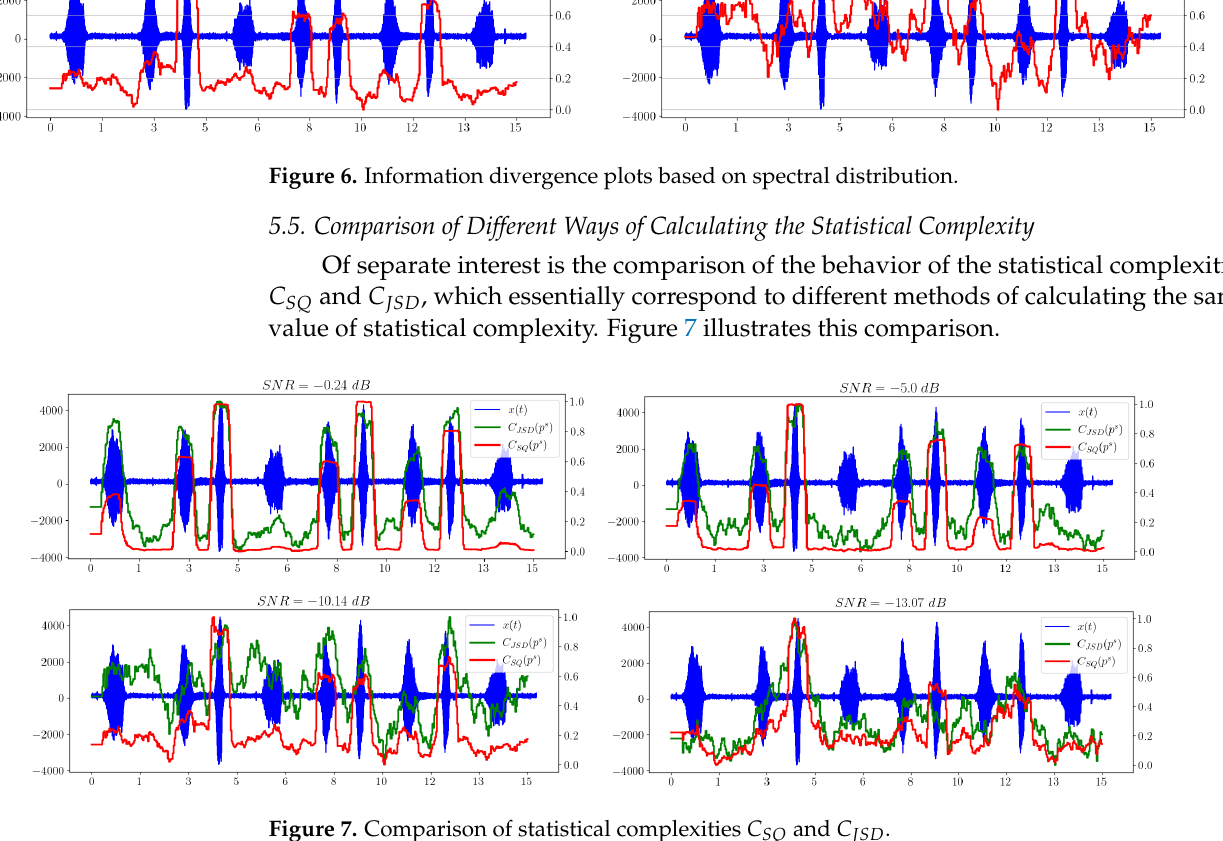
Figure 7. Comparison of statistical complexities C SQ and C JSD